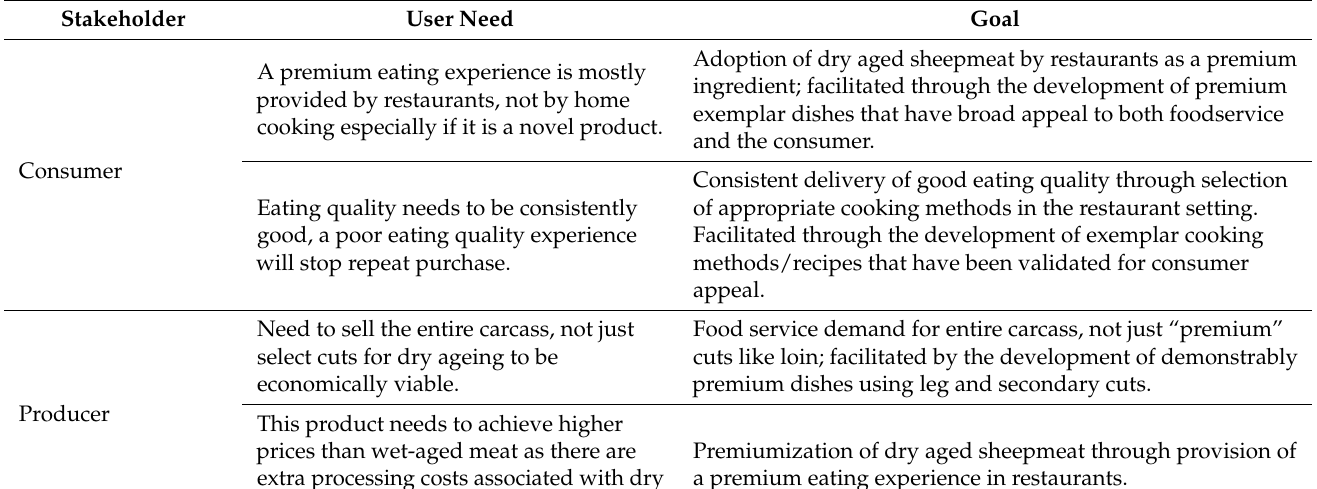
Table 5. Dry aged sheepmeat user needs and